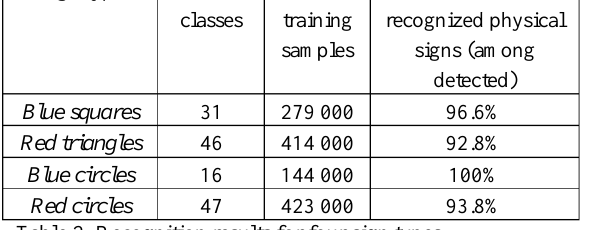
Table 2: Recognition results for four sign types.